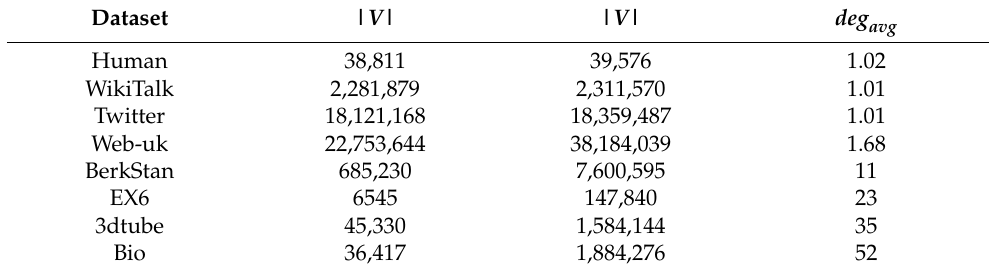
Table 3. Statistics of real datasets, where d denotes the average degree ( deg avg = | E | / | V | ) .